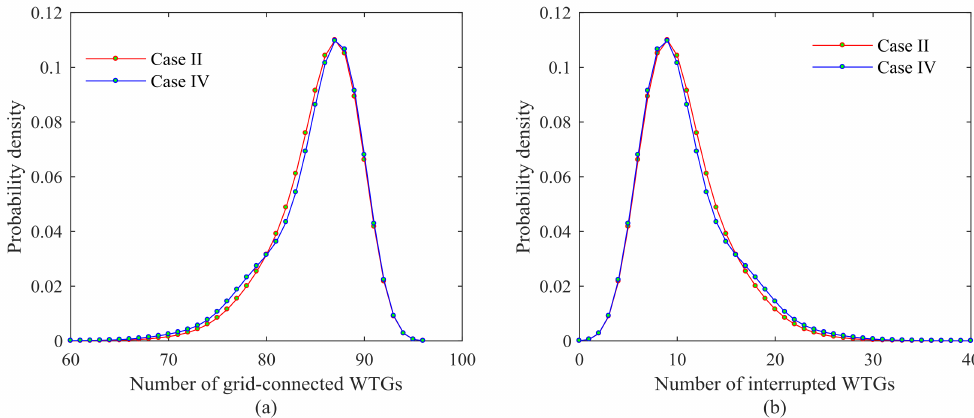
Figure 6. Probabilities of ( a ) grid-connected WTGs number and ( b ) interrupted WTGs